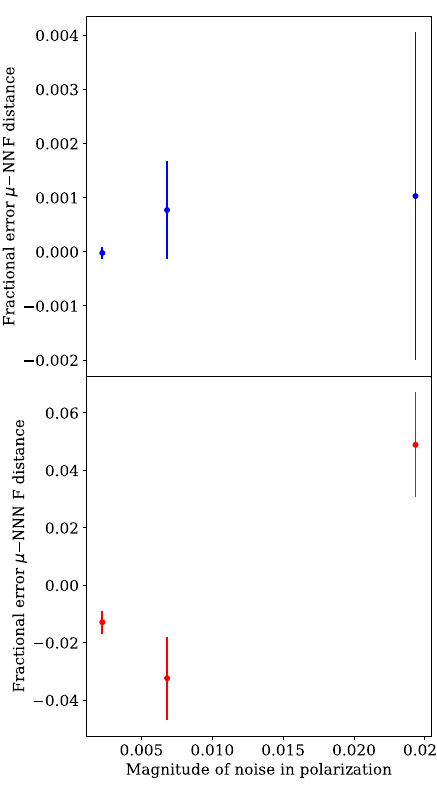
FIG. 15. Fractional error in the geometric fitting parameters used to fit the simulated muon-spectroscopy data to the experi- mental data in Fig. 14. The noiseless values of the parameters are obtained through exact diagonalization of the 11-qubit Hamilto- nian to obtain a polarization function, which is fitted using the Nelder-Mead